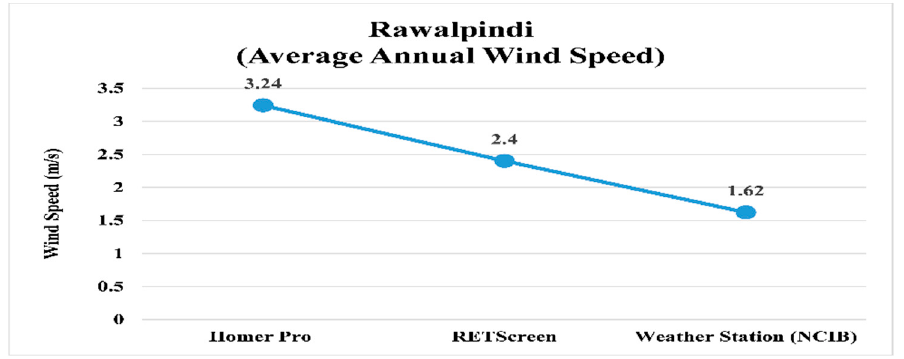
Figure 4. Comparison and validation of average annual wind speed data between HOMER Pro, RETScreen, and real-time data.